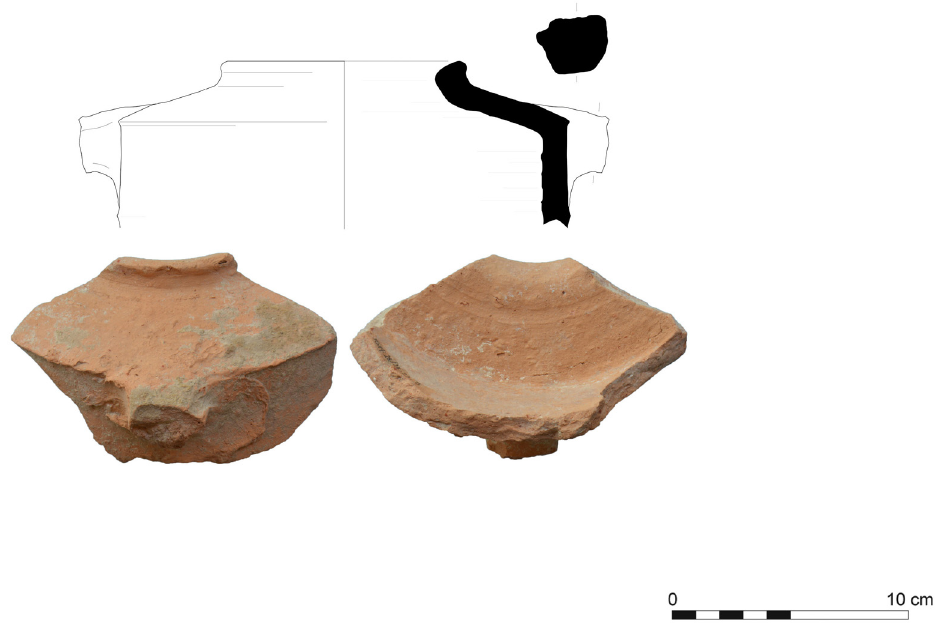
Figure 5: Digital drawing and photographs